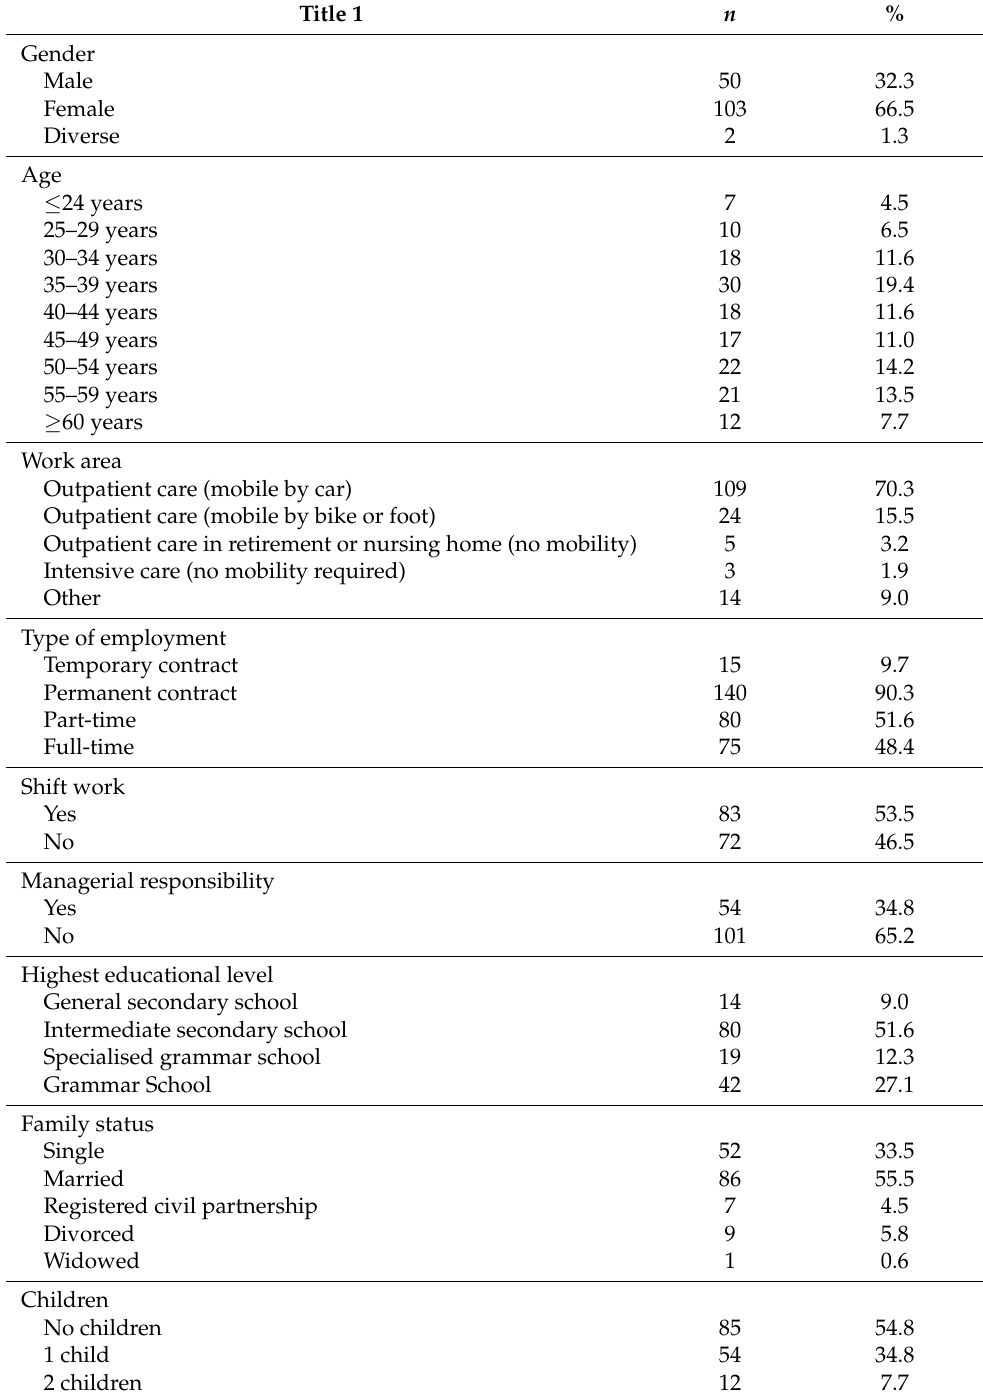
Table 1. Sociodemographic characteristics of participants ( N =